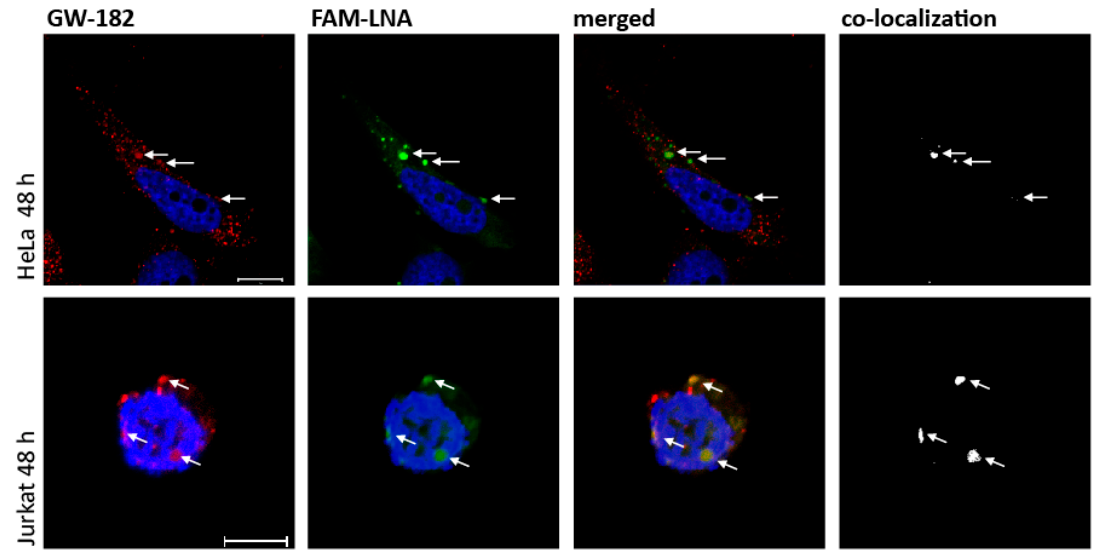
Figure 3. Co-localization of gymnotically-delivered 6-FAM™-SRSF6 ExJ 3/4 LNA mixmer with GW 182. HeLa or Jurkat cells were incubated with the 6-FAM™-SRSF6 ExJ 3/4 LNA. 48 h after gymnotic LNA delivery cells were fixed, permeabilized and incubated with a GW-182 antibody to detect GW-bodies. To monitor co-localization of the 6-FAM™-SRSF6 ExJ 3/4 LNA with GW-182, confocal laser scanning microscopy was performed. Red: GW-182; green: 6-FAM™-SRSF6 ExJ 3/4 LNA; white: Co-localization channel defining co-localized fluorescence. White bars: HeLa cells (10 µm), Jurkat cells (5 µm).